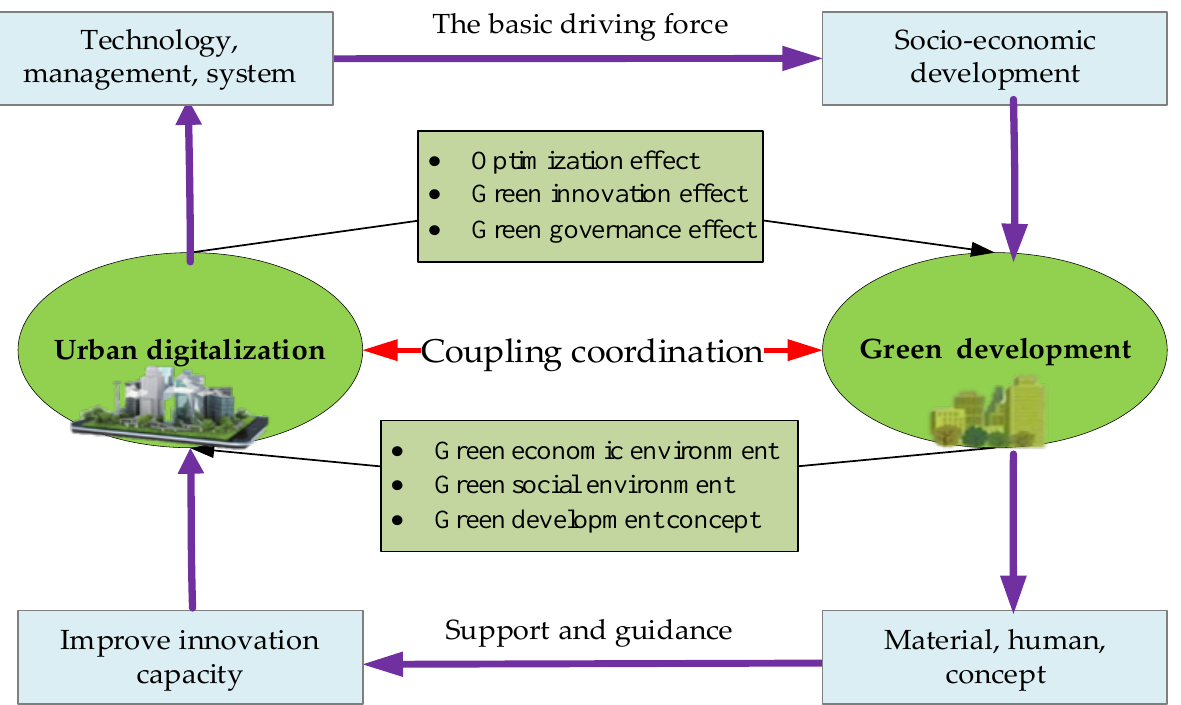
Figure 1. Coupling coordination mechanism of urban digitalization and green development.